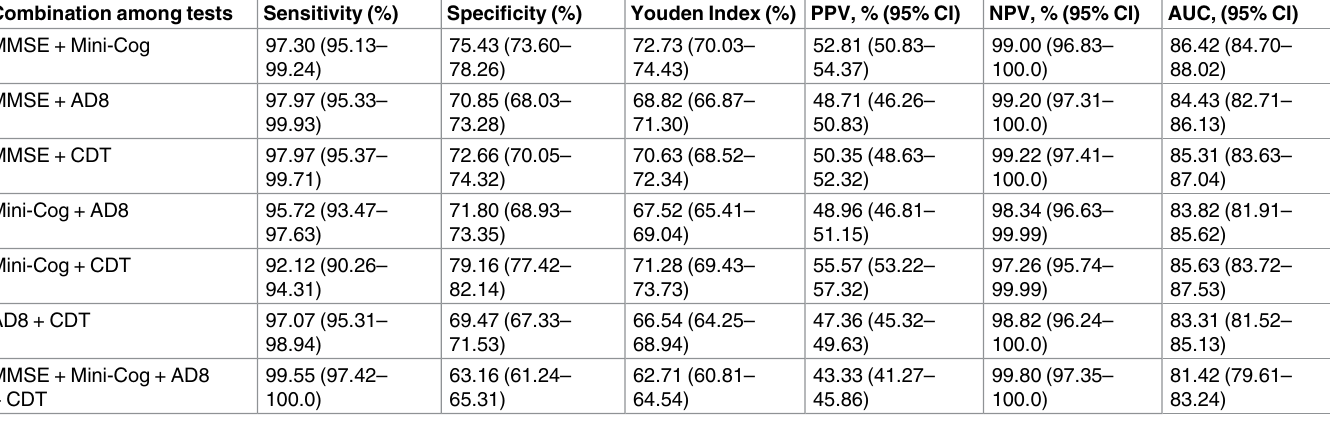
Table 4. Diagnostic test characteristics of the parallel mode combinations among screening tools #